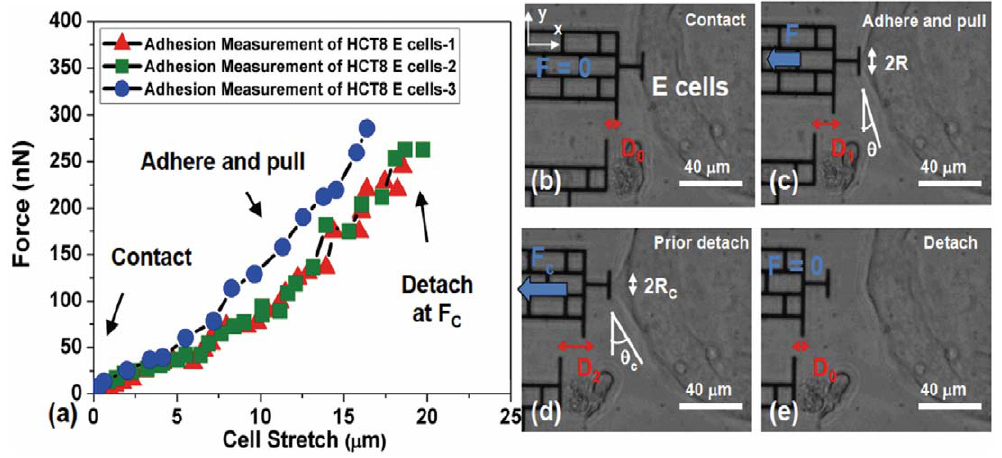
Figure 5. Measurement of E cell island intercellular adhesion by determining detachment force using a Bio-MEMS probe. (a) Intercellular adhesive detachment force of a cell island on the MEMS probe. The force increases monotonically with stretch until detachment. (b–e) Phase contrast images of one typical adhesion experiment. Force is calculated from the deformation of the sensor beam D and the force-deformation calibration curve. The critical detachment force, F c , is the maximum force on the force-displacement curves. During stretching, the contact angle h between the probe and the cell island increases, but the contact zone size between the probe and the cell island keeps reducing. Scale bar =40 um.